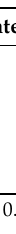
Table 1. By-products synthesized during 48 h of incubation.